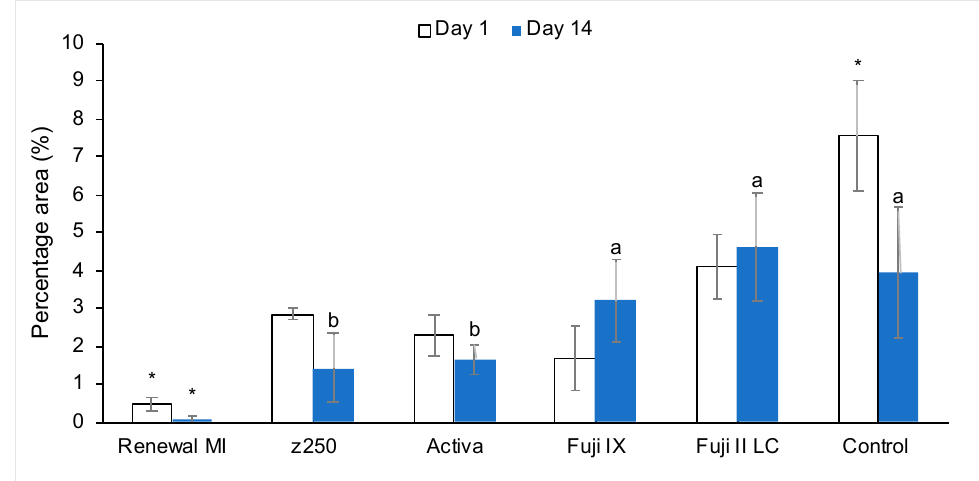
Figure 7. Green fluorescence area as a percentage of CLSM images of enzyme activity. This indicates the relative level of interface MMP activity on demineralized dentine restored with different materials (1 or 14 days). * indicates significant difference from all other groups. Sharing the same letter (a or b) means no significant difference between these groups. Error bars are 95% CI ( n = 3).